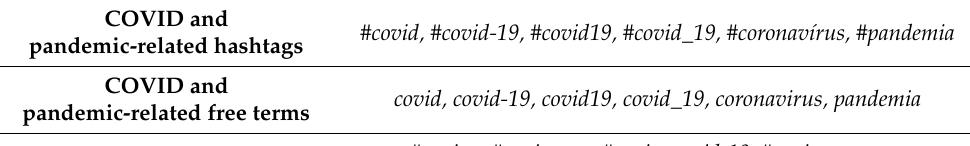
Table 2. Terms used to retrieve tweets for the corpus for